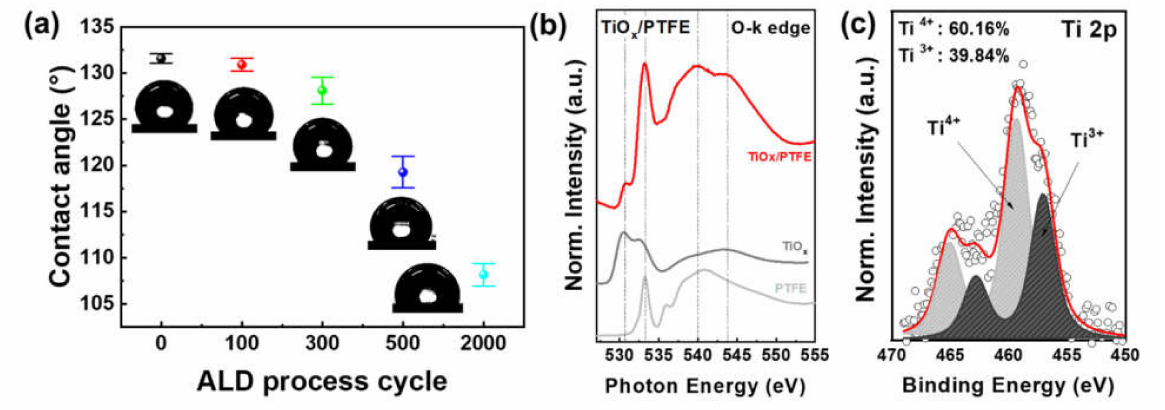
Figure 2. Effects of the ALD-TiO x layer on the surface property. ( a ) Changes in the contact angle with an increase in number of ALD cycles. ( b ) Oxygen- κ edge XAS spectra of pristine PTFE (light gray), TiOx (gray), and ALD-TiO x /PTFE films (red). ( c ) Deconvoluted Ti 2 p XPS spectrum of the ALD-TiO x layer with 300 ALD